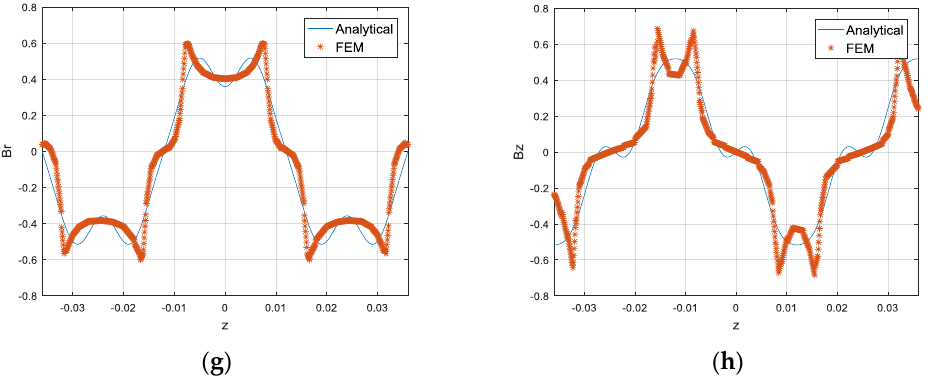
Figure 11. Comparison of analytical model and numerical result: ( a ) Radial flux density on line 1; ( b ) Axial flux density on line 1. ( c ) Radial flux density on line 2; ( d ) Axial flux density on line 2. ( e ) Radial flux density on line 3; ( f ) Axial flux density on line 3. ( g ) Radial flux density on line 4; ( h ) Axial flux density on line 4.